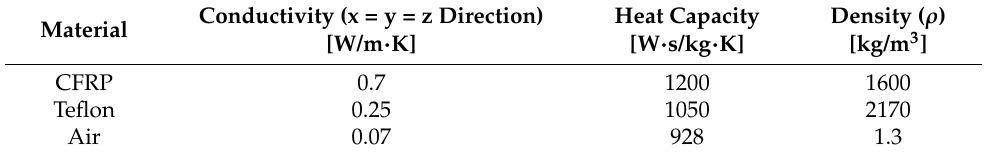
Table 3. Properties of the materials